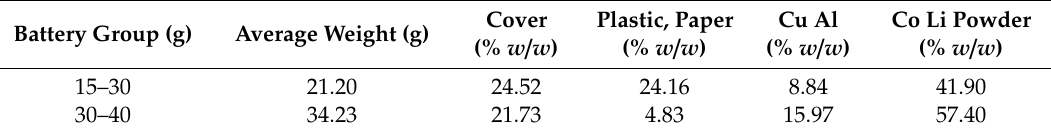
Table 2. Material percentage % ( w / w ) present in LiBs.